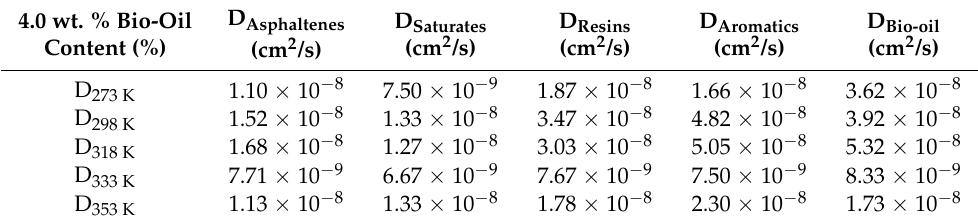
Table 6. Diffusion coefficients at different temperatures.